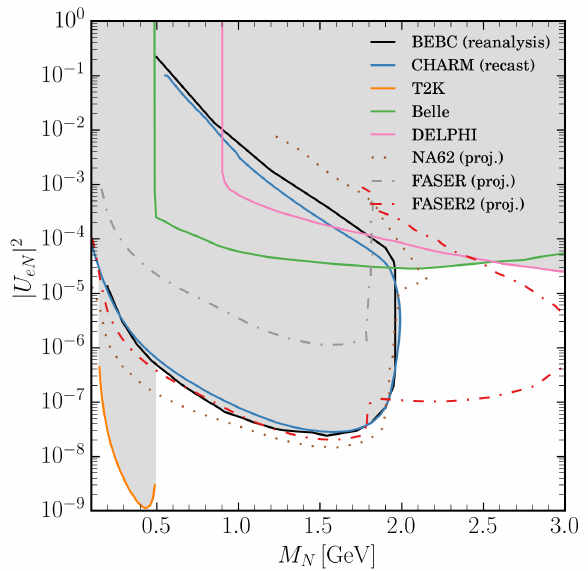
Figure 5: The 90% exclusion region in the HNL mass versus its mixing with ν this reanalysis of BEBC WA66. The recast bound [ 13 ] from CHARM is also shown, as are bounds from T2K [ 6 ] , Belle [ 10 ] , and DELPHI [ 15 ] , as well as the projected sensitivities of NA62 in beam dump mode [ 55 ] and FASER / FASER2 [ 57 ]